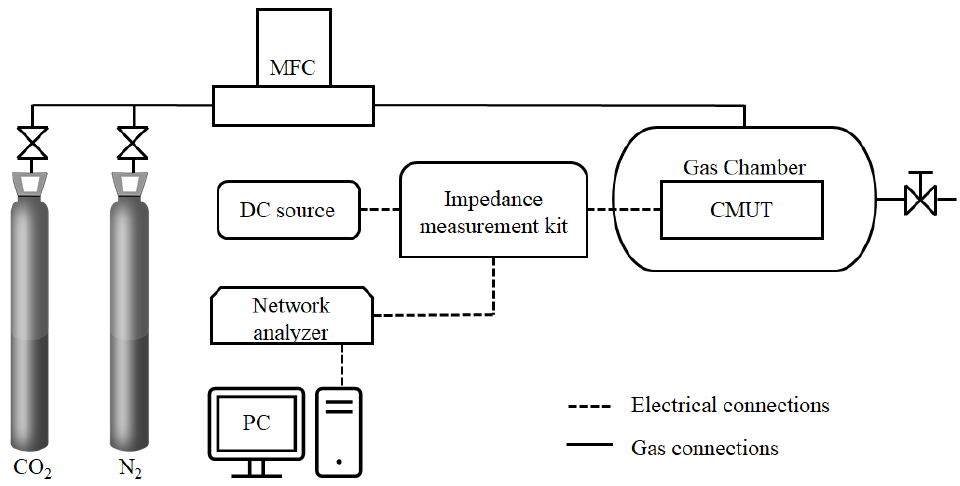
Figure 3. Block diagram of the experimental system setup for sensor testing in CO 2 and N 2 gas envi-